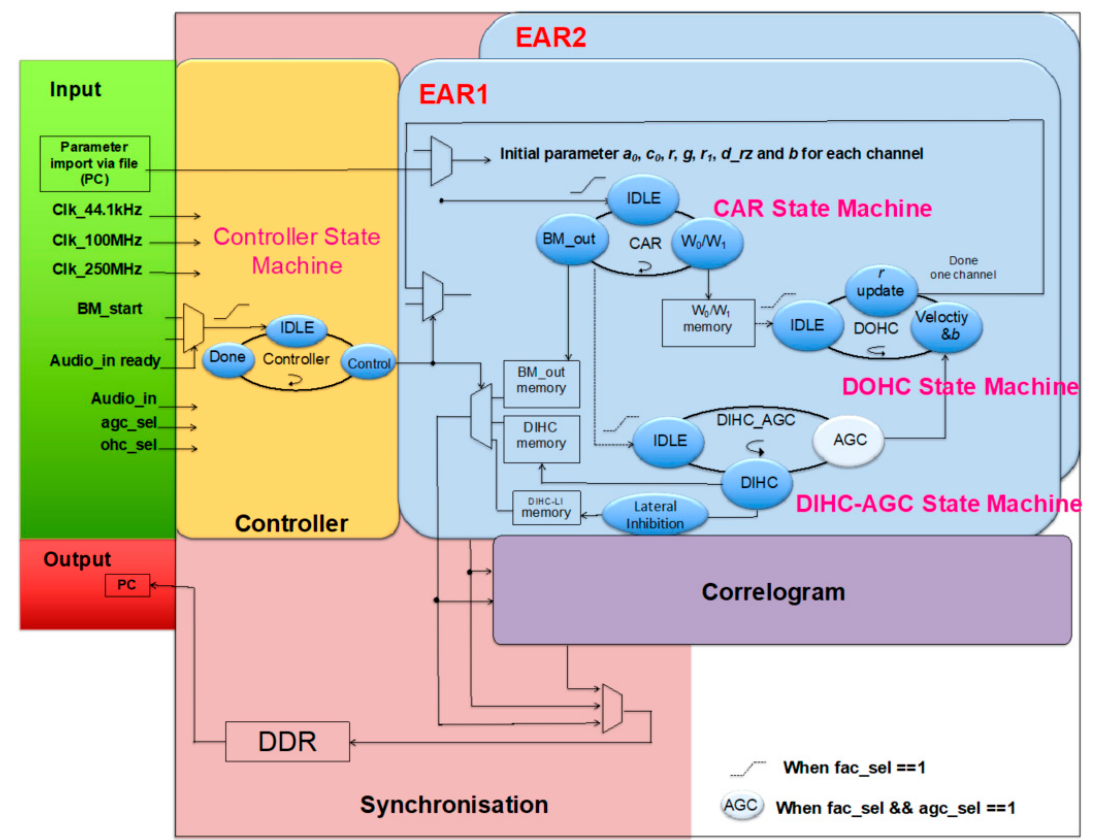
Figure 2. The binaural CAR-FAC system architecture. The system consists of an audio codec, a controller, a synchronisation circuit, an external Double Data Rate Synchronous Dynamic Random Access Memory (DDR) and two ‘ears’. Each ear includes a CAR FAC module. The system provides two ways for sound input. One way is through the SSM2603 audio codec on the FPGA board, and a second provides recorded audio file input from the PC host through a USB 3.0 interface. There are two clock domains in the system: a system clock domain (250 MHz) and a synchronisation clock domain (100 MHz). The system clock domain includes the controller, the two CAR-FACs, and the Correlogram module. The synchronisation clock domain is unique to the synchronisation unit. The external memory is a 1 GB DDR3 SDRAM on the FPGA board: it stores the CAR-FAC output or the correlogram via a selector. The USB interface communicates between the FPGA board and the PC, and transmits the system’s initial parameters, and, if required, the input audio file from the PC to the FPGA board. The controller state machine determines the cochlear channel to be processed at any particular time and controls the CAR-FAC coefficients and data for that channel. The BM_start signal controls the start of the system through the controller, and it is triggered by the “Audio_in ready” signal. The ohc_sel is a selector switch for the CAR/CAR-FAC function. The agc_sel is a switch for the AGC loop function. The CAR state machine calculates the CAR transfer function and controls the DOHC and DIHC_AGC start in the system. The DOHC state machine calculates OHC function and feeds back an updated r to the CAR. The DIHC-AGC calculates the IHC function, as well as the AGC_loop function. The AGC output b feeds back to the DOHC module. The details of the module are presented in References [38,39]. The DIHC-LI outputs of the two ‘ears’ are used to generate correlograms in the correlogram module, which is presented in Reference [36]. The FPGA board is hosted by a PC through the USB